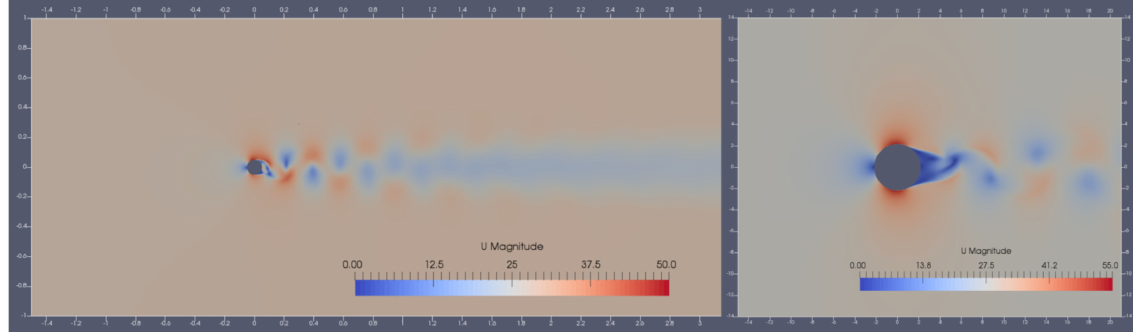
Figure 6. Flow speed around an element of the helideck frame ( left ) and the lantern in isolation ( right